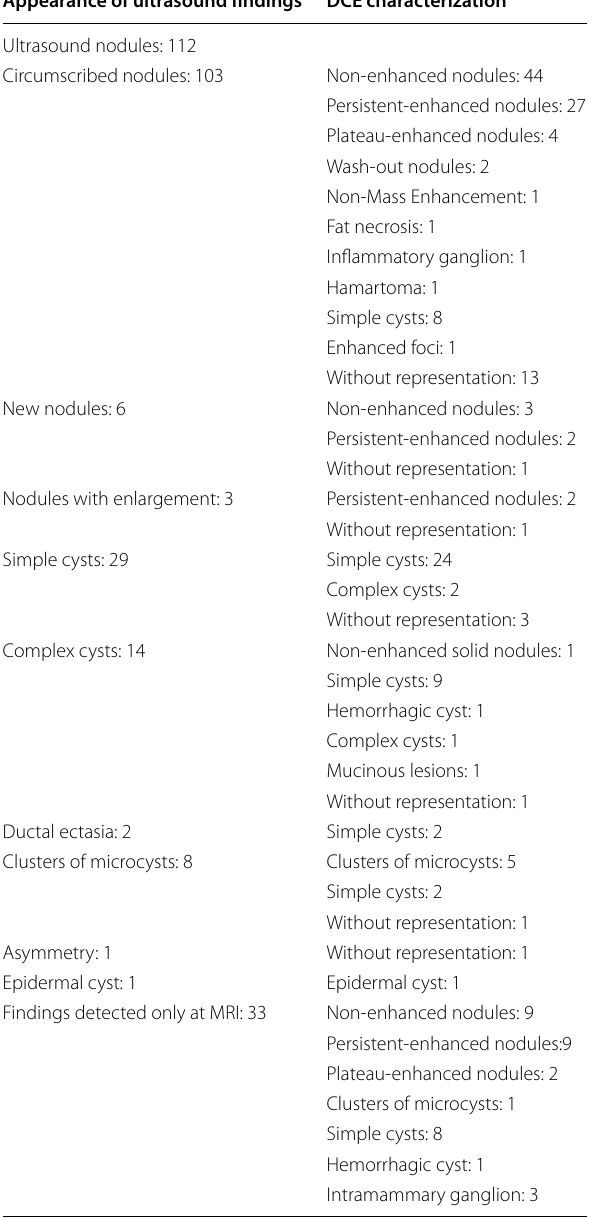
Table 5 Ultrasonography and Mammography findings Vs DCE characterization of BI‑RADS 3 patients Appearance of ultrasound findings DCE